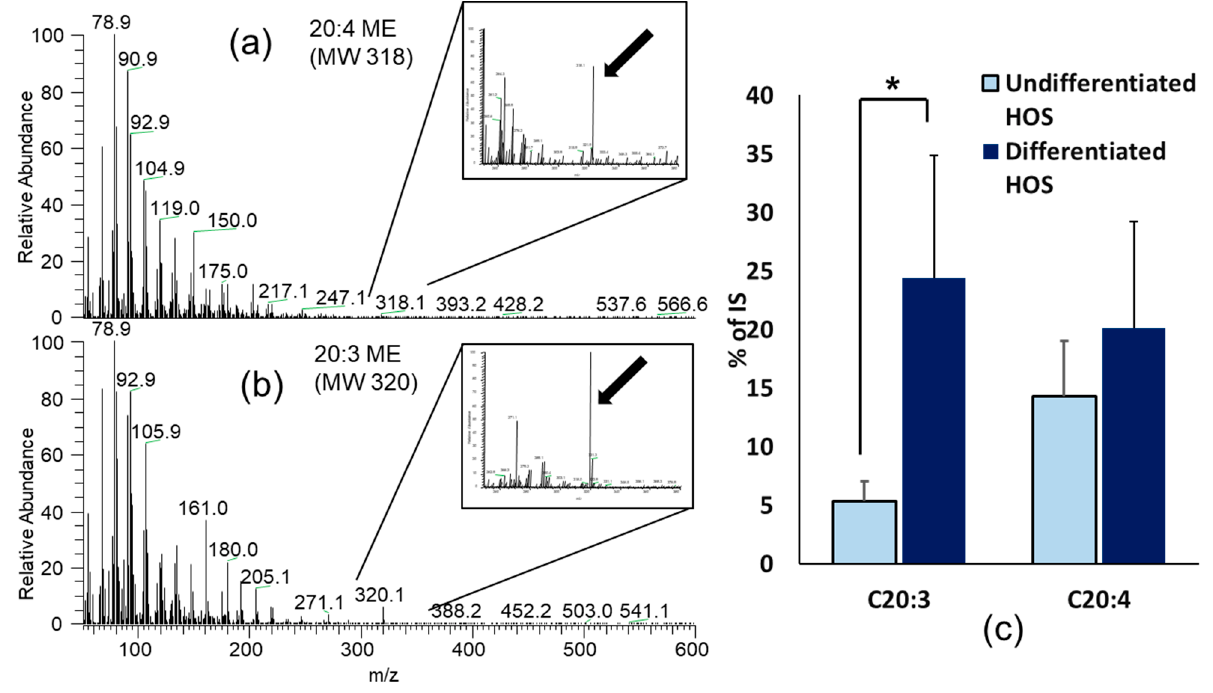
Figure 8. Fatty acid analyses. ( a ) Arachidonic acid, 20:4 (MW 318) and ( b ) mead acid 20:3, (MW 320); ( c ) amounts of 20:3 and 20:4 in undifferentiated and differentiated HOS normalized with internal standard. Amount of C20:3 was different between cultures, * p < 0.05.